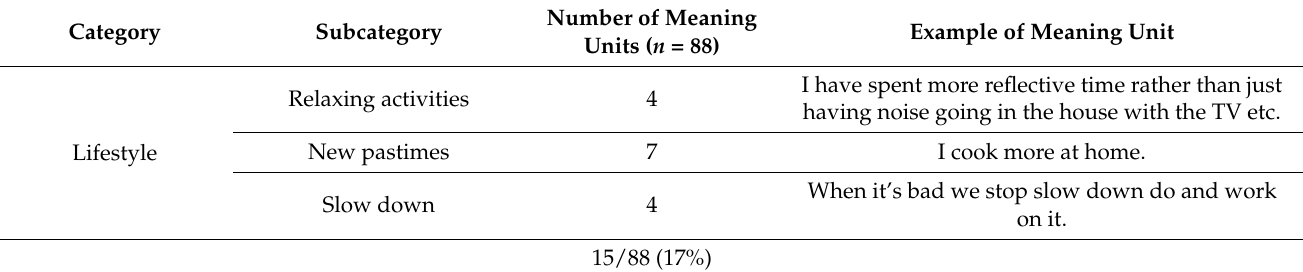
Table 5. Positive experiences of tinnitus on significant